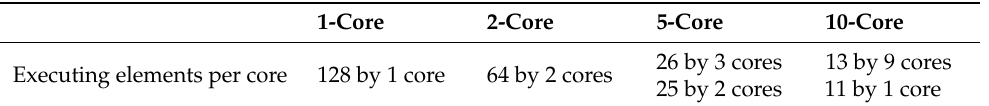
Table 6. Task assignments for each system.